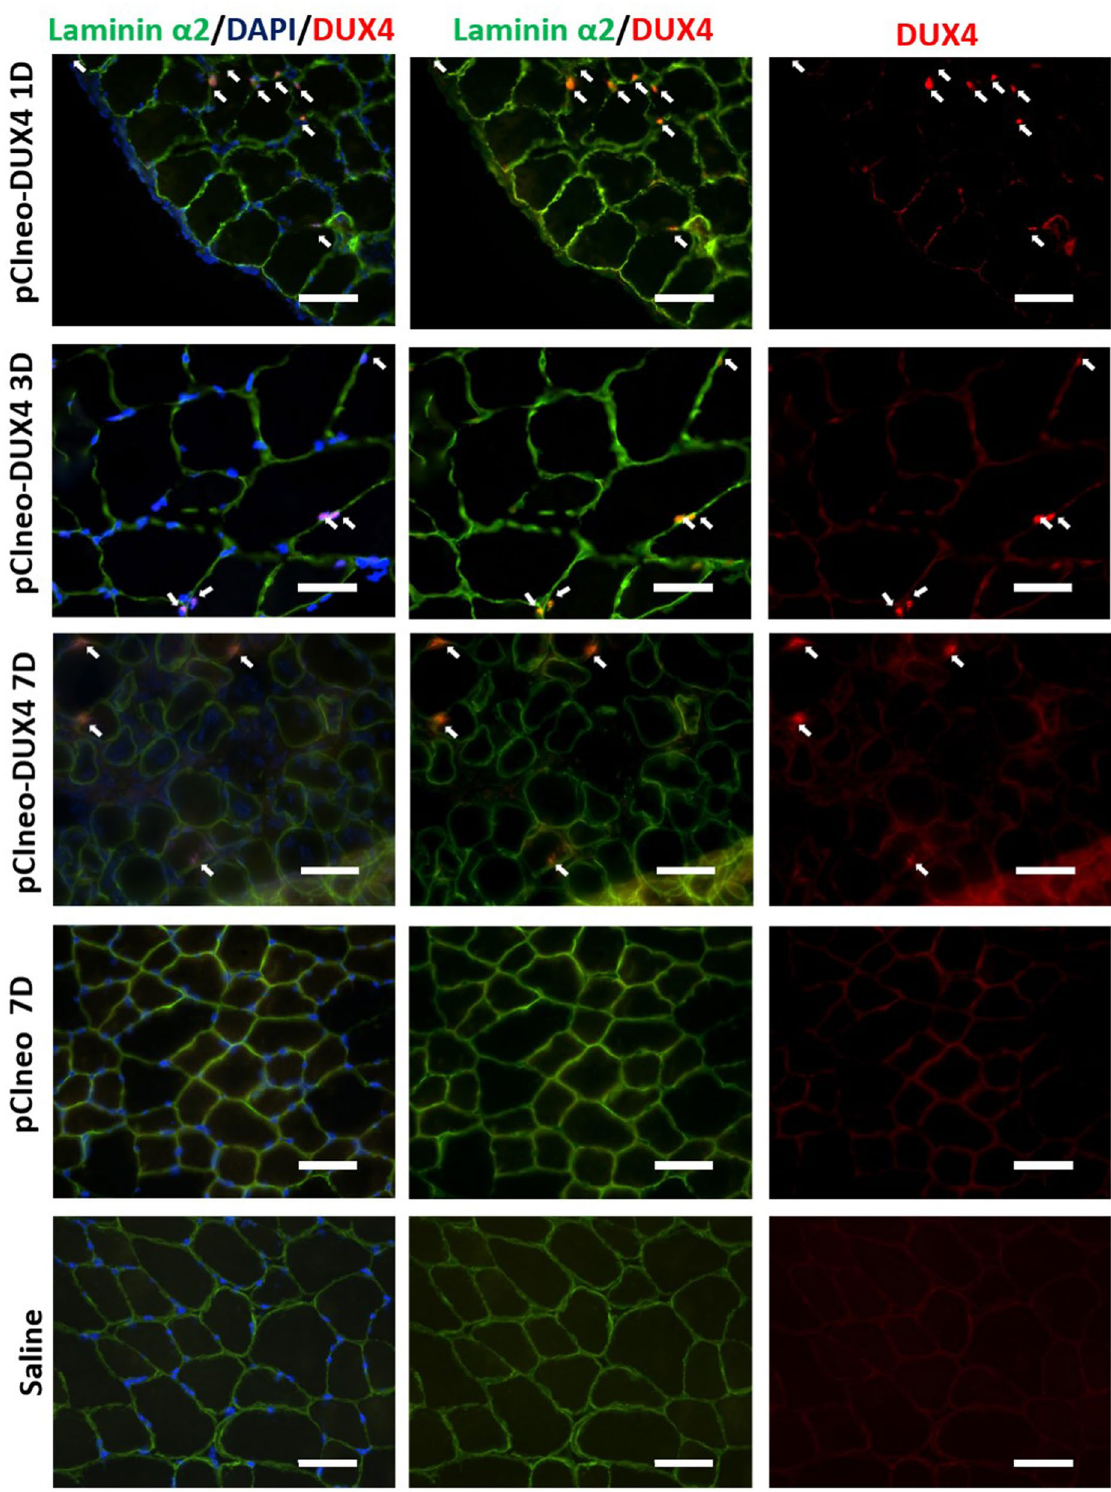
Figure 7. Confirmation of DUX4 protein expression by Immunofluorescence. Mouse TAs were injected by hIMEP with 10 µg pCMV-lacZ plasmid concomitantly with 40 µg either pCIneo-DUX4 or pCIneo , or with a saline solution (negative control), as indicated. Cryosections were analyzed 1, 3 and 7 days post-injection by immunofluorescence with antibodies directed against either DUX4 (E5-5) (red) or laminin α2 (green) to stain the myofibre basal lamina (for details, see “Methods”). DAPI was used to visualize nuclei (blue). Pictures were taken with a Nikon Eclipse 80i microscope and merged using NIS-Elements software. Scale bar 50